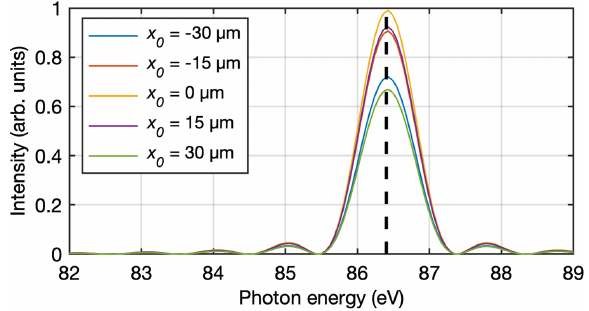
FIG. 6. Simulated on-axis spectra for different initial x